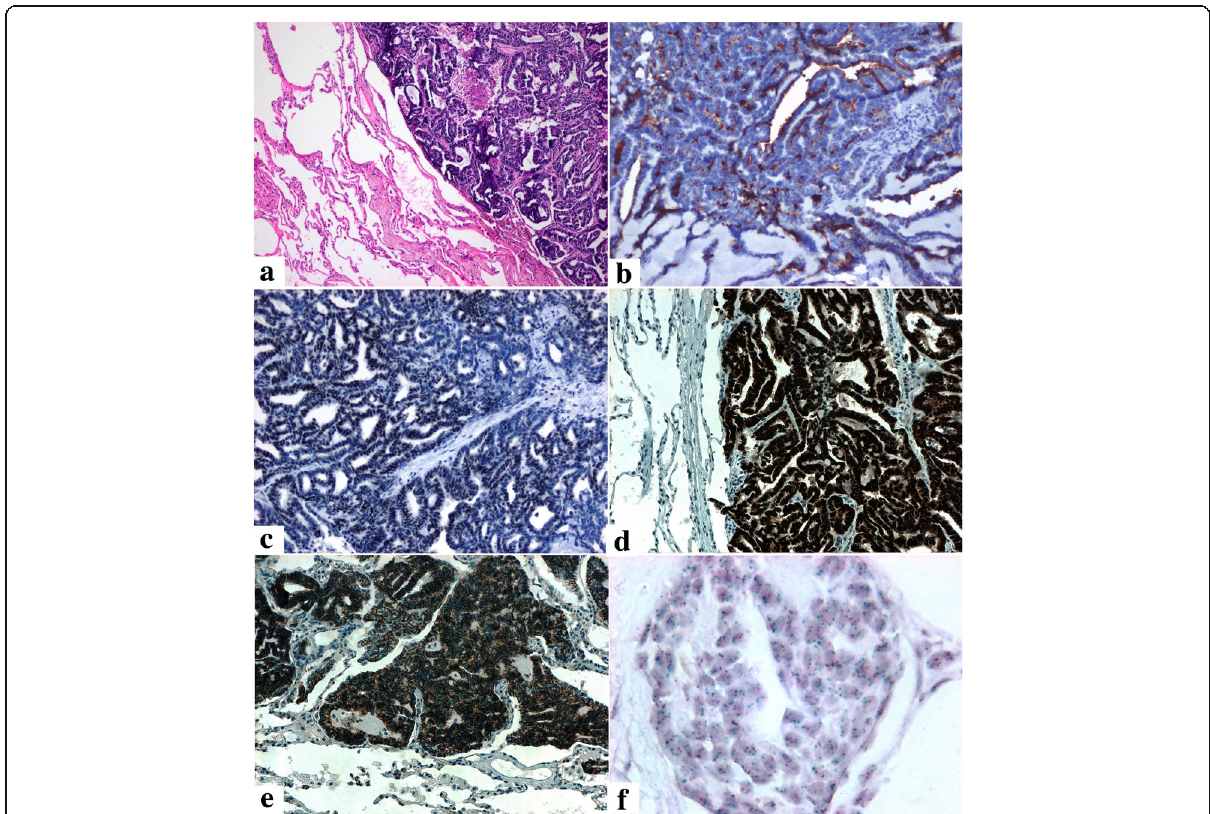
Fig. 2 Lung metastasis of the endocervical mesonephric adenocarcinoma. Malignant tumor with a tubular, ductal, and papillary histological pattern (were very similar to the endocervical tumor) [HE 10X] ( a ). The neoplastic cells were positive for CD10 (luminal pattern), TTF-1, PAX-8 and Beta-catenin (membrane stain) ( b , c , d , e ). Chomogenic in Situ Hybridization (CISH) of 1q and 1p. Gain of 1q (green) and normal copy number of 1p (red) are shown, with one to two copies of 1p36 and three to eight copies of 1q25 ( f